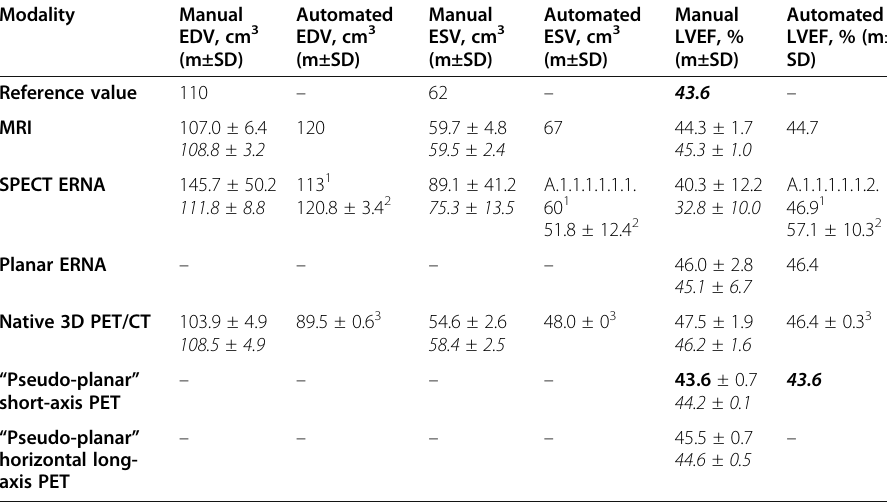
Table 2 Left ventricle end-diastole and end-systole volumes and ejection fraction of the heart- phantom pair. These values were measured with four imaging modalities and calculated with manual and automated